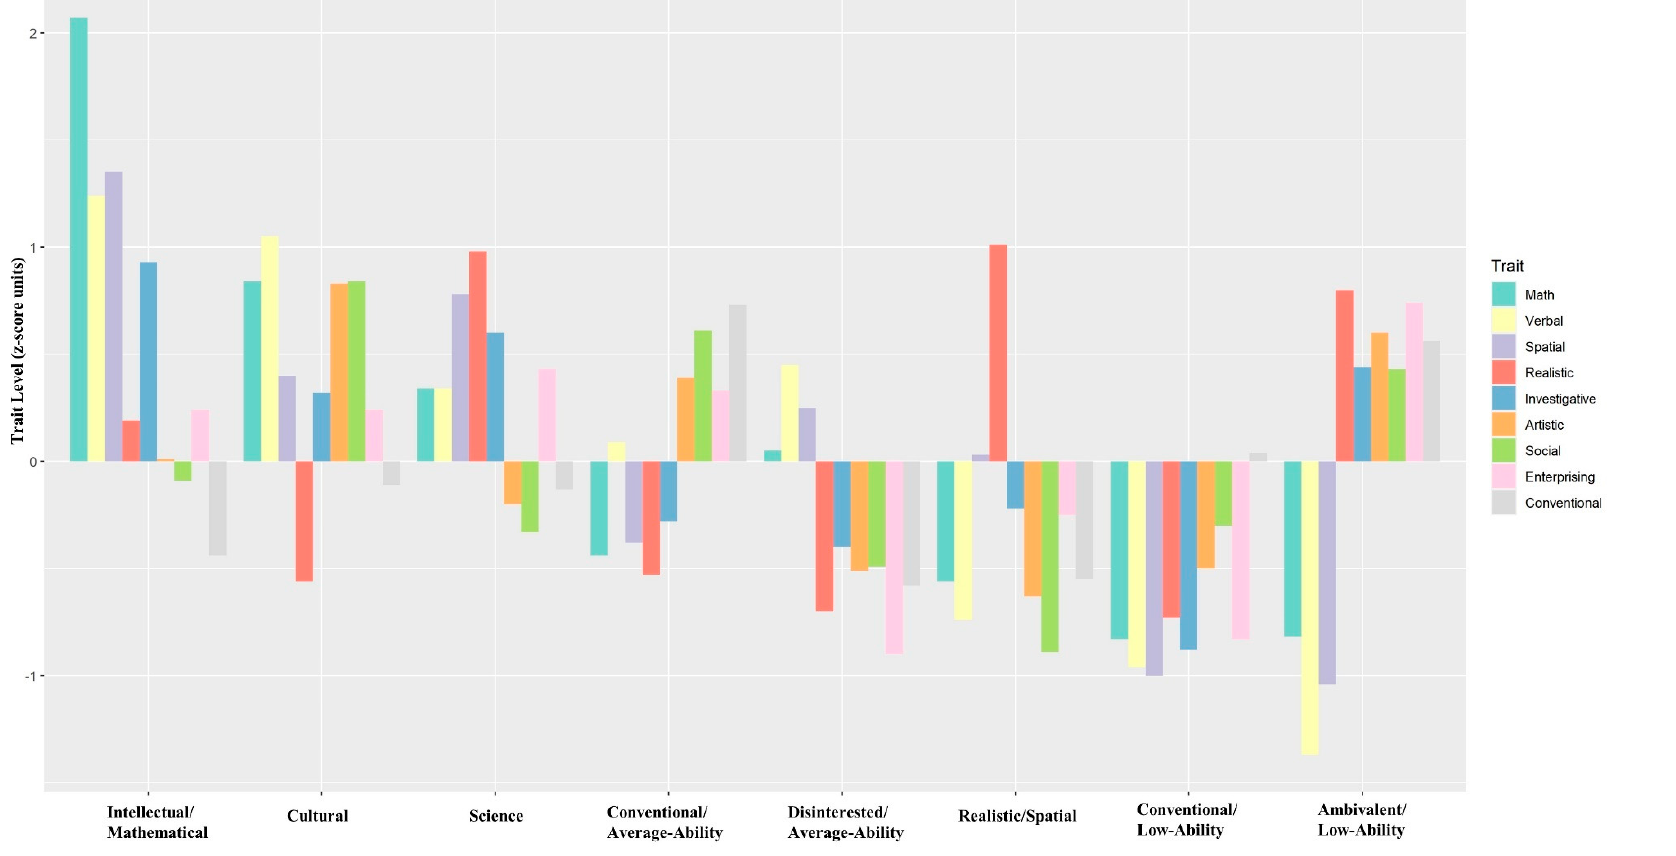
Figure 1. Profiles resulting from latent profile analysis. Note : The proportion of participants in each profile is as follows: intellectual/cultural = 9.76%, cultural = 11.29%, science = 13.55%, conventional/average-ability = 19.94%, disinterested/average-ability = 10.00%, realistic/spatial = 12.11%, conventional/low-ability = 14.21%, and ambivalent/low-ability = 9.13%. Standard errors for profile trait means were all less than 0.05 z-scores.